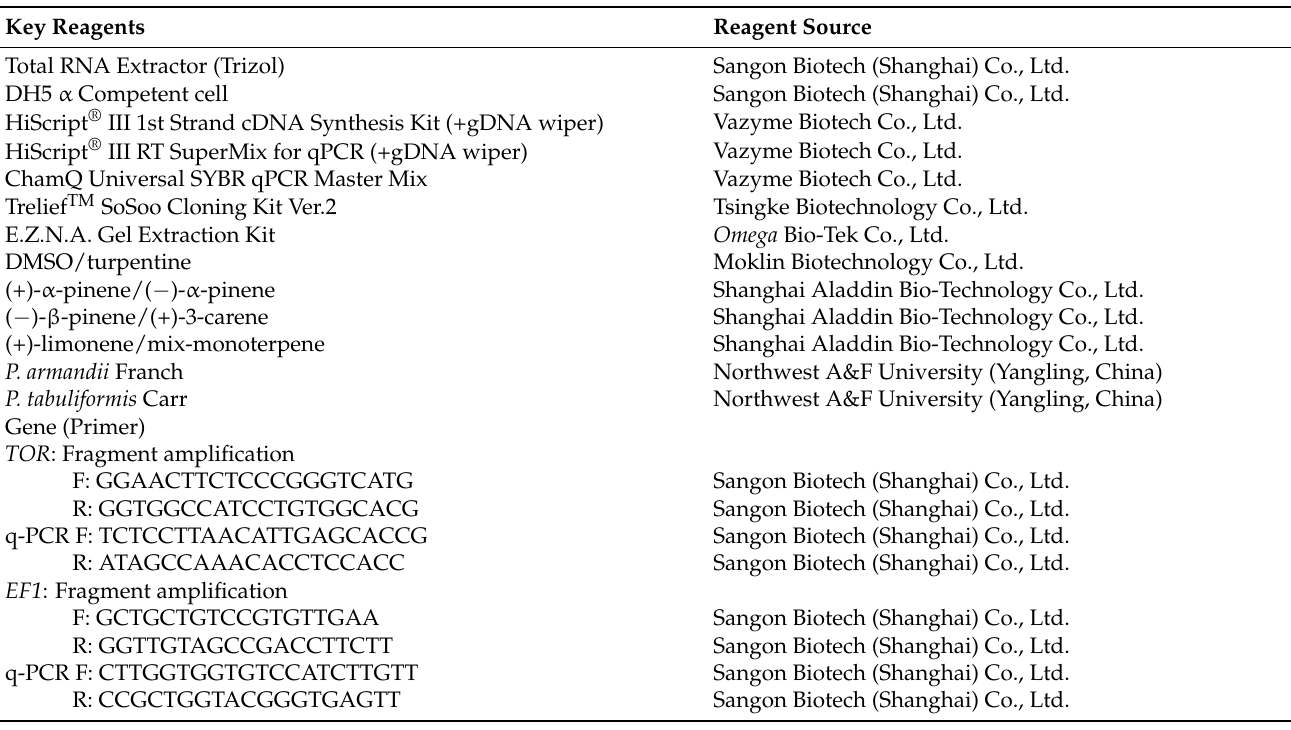
Table 1. Description of the main reagents and primers used in this